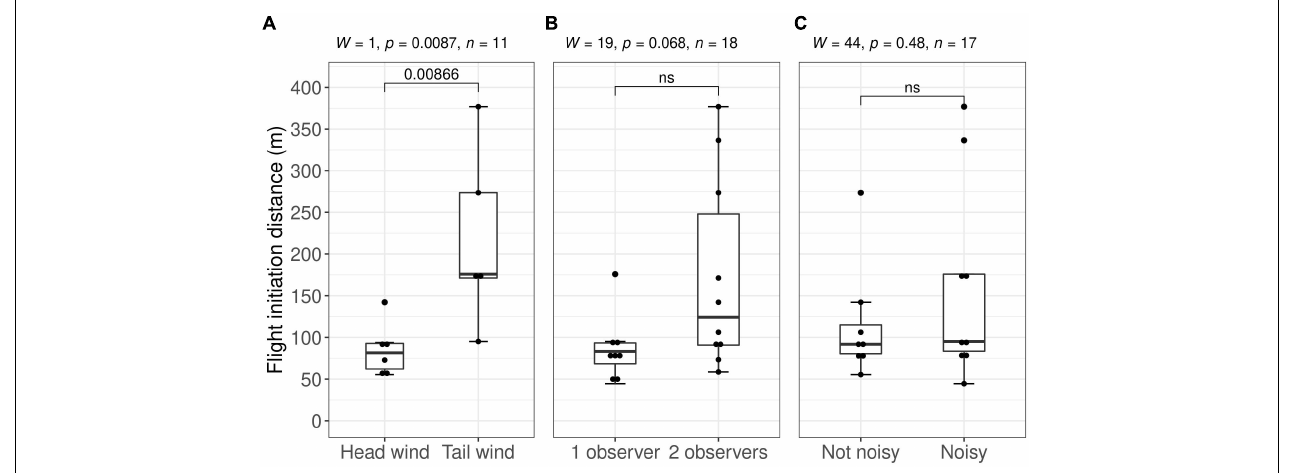
FIGURE 2 | Distribution of flight initiation distances (meters) with (A) head wind (wind from the wolf toward observer, N = 6) vs. tail wind (wind from observer toward the wolf, N = 5), (B) single-observer approach ( N = 8) vs. double-observer approach ( N = 10), and (C) not noisy ( N = 8) vs. noisy sounds ( N = 9) by walking through the vegetation. Using the non-parametric Wilcoxon rank-sum test based on experimental approach trials by humans on wolves in south-central Scandinavia, 2018–2021.